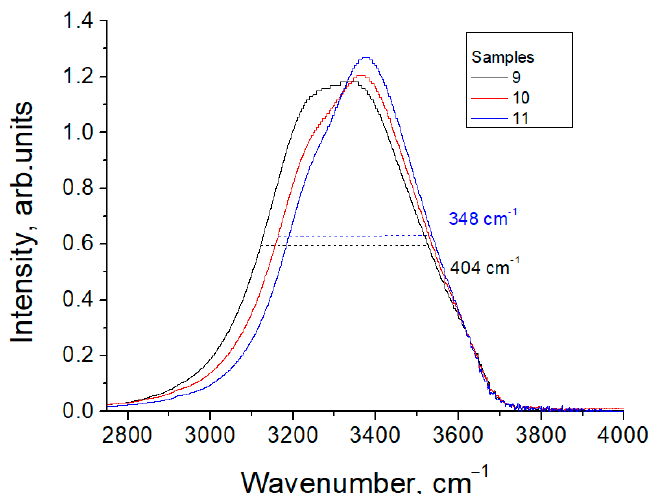
Figure 6. Regions of the IR spectra of samples 9–11. The widths (dashed lines) of the bands of the samples 9 and 11 at half peak intensity are indicated.